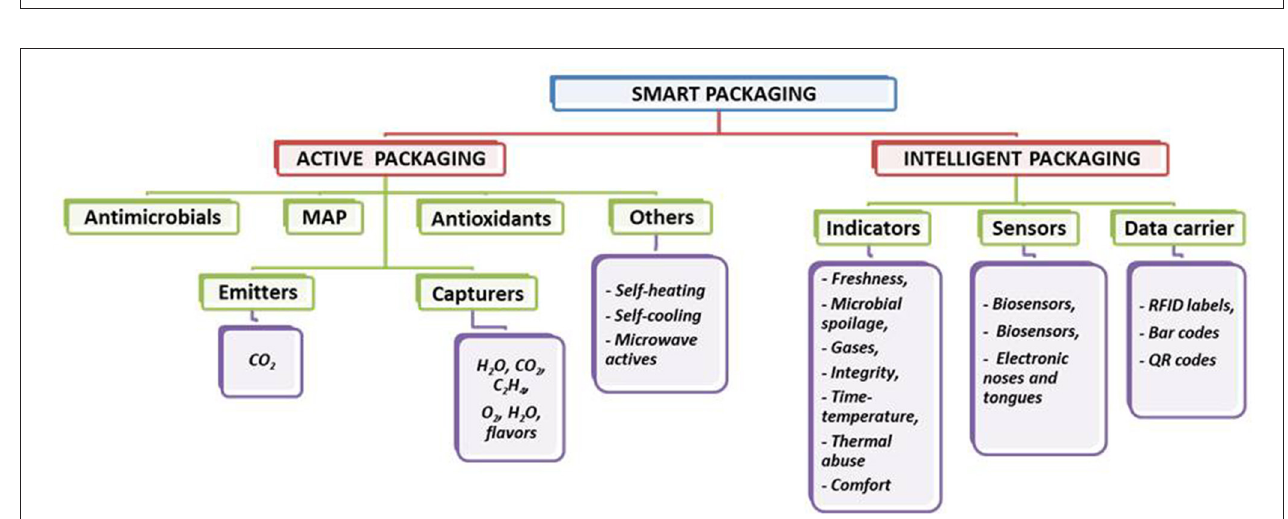
FIGURE 8 | Classification of smart food packaging described in this